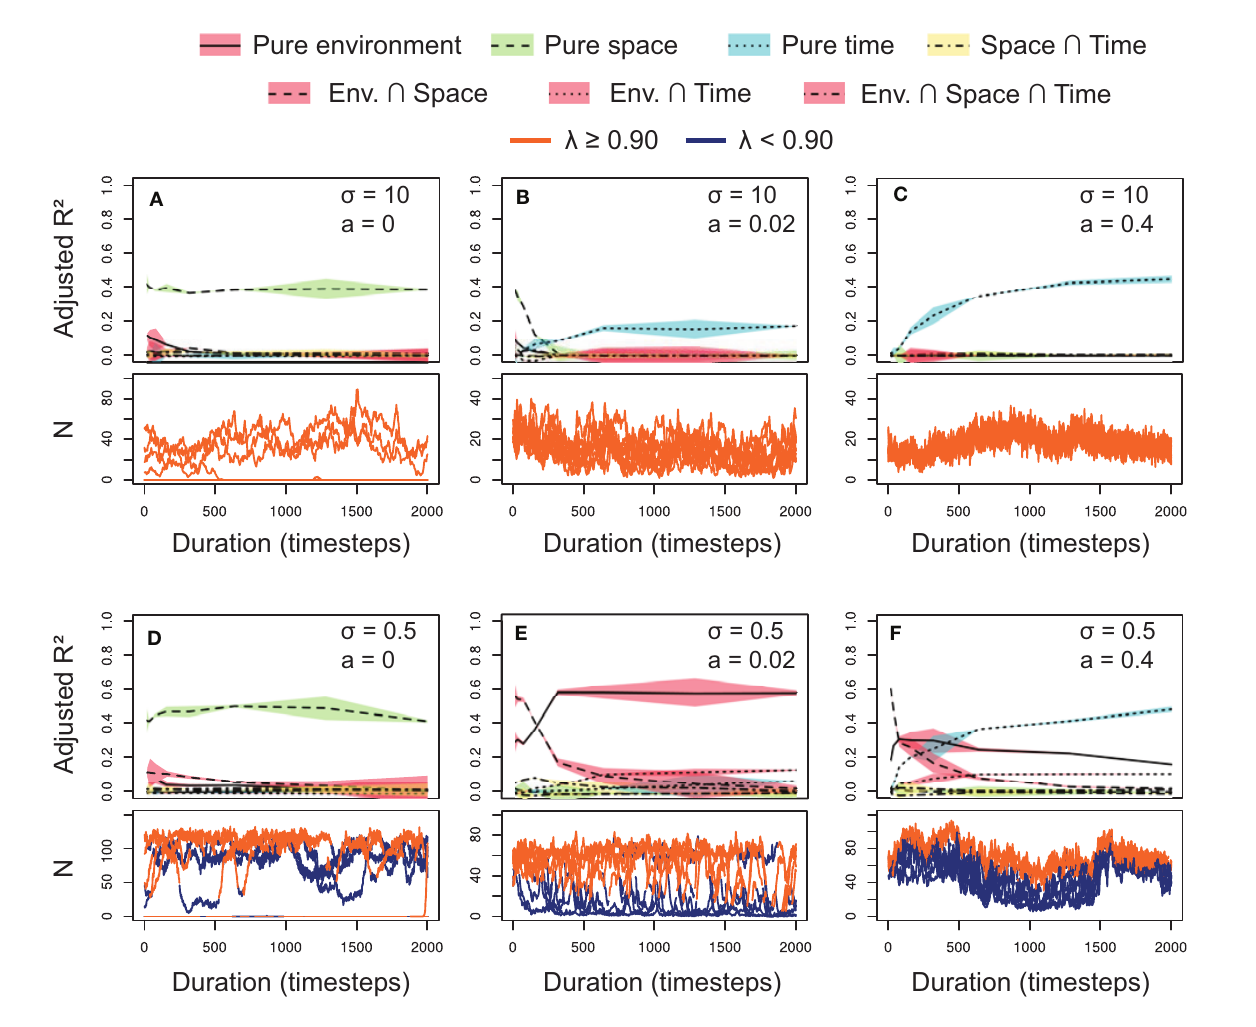
FIGURE 3 | Relative importance (adjusted R 2 ) of the explanatory sets on the variation of simulated metacommunities under different scenarios of niche differentiation ( σ : broad in A–C vs. narrow in D–F ) and dispersal rate ( a : low in A,D , intermediate in B,E and high in C,F ) in a gradient of study durations (top subpanels, A–F ). The lines represent the mean, and the colored pattern the standard error of the adjusted R 2 of the 10 replicated simulations. The bottom subpanels display the associated temporal changes in abundance ( N ) of one random species in 10 localities represented with different lines. The color of the lines depend on the environmental performance of the species in each locality through time, being orange under favorable and blue under unsuitable conditions (with a threshold of λ =